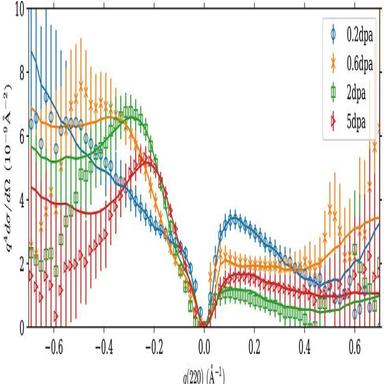
Diffuse scattering cross-sections along the direction around the (220) Bragg peaks in Cu implanted W. The solid lines are refinements to the measured diffuse scattering intensity. The figure shown here is identical to Figure 4 in ref .